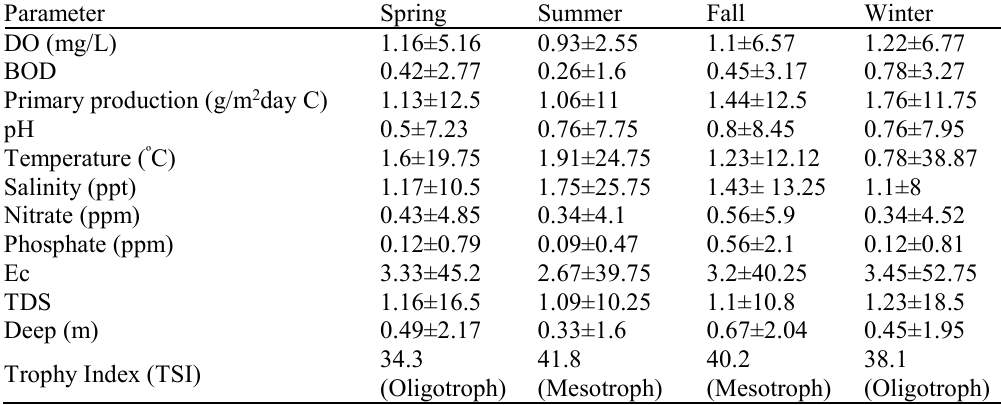
Table 1. Physicochemical parameters of water (trophic index and TSI) in different seasons in Choghakhor wetland, Iran (2017-2018) Parameter Spring Summer Fall DO